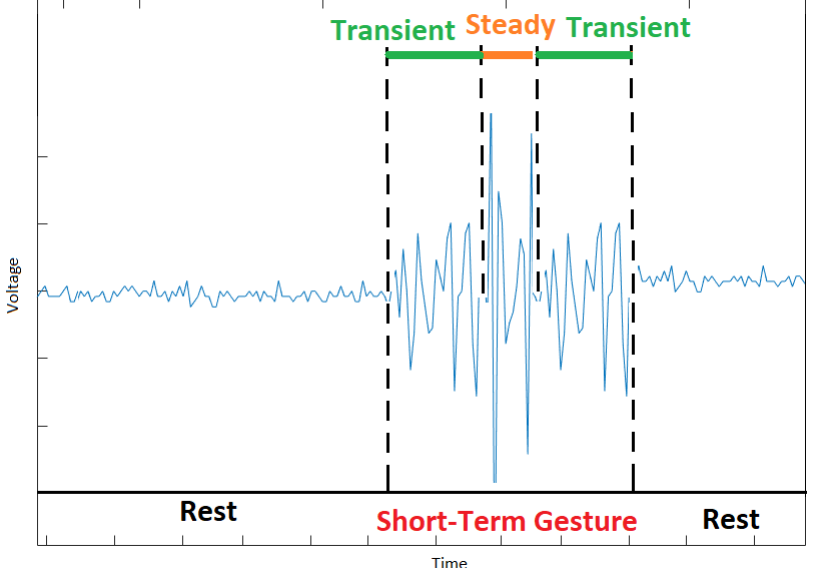
Figure 6. The EMG data of a short-term peace gesture (most of the EMG data are in the transient